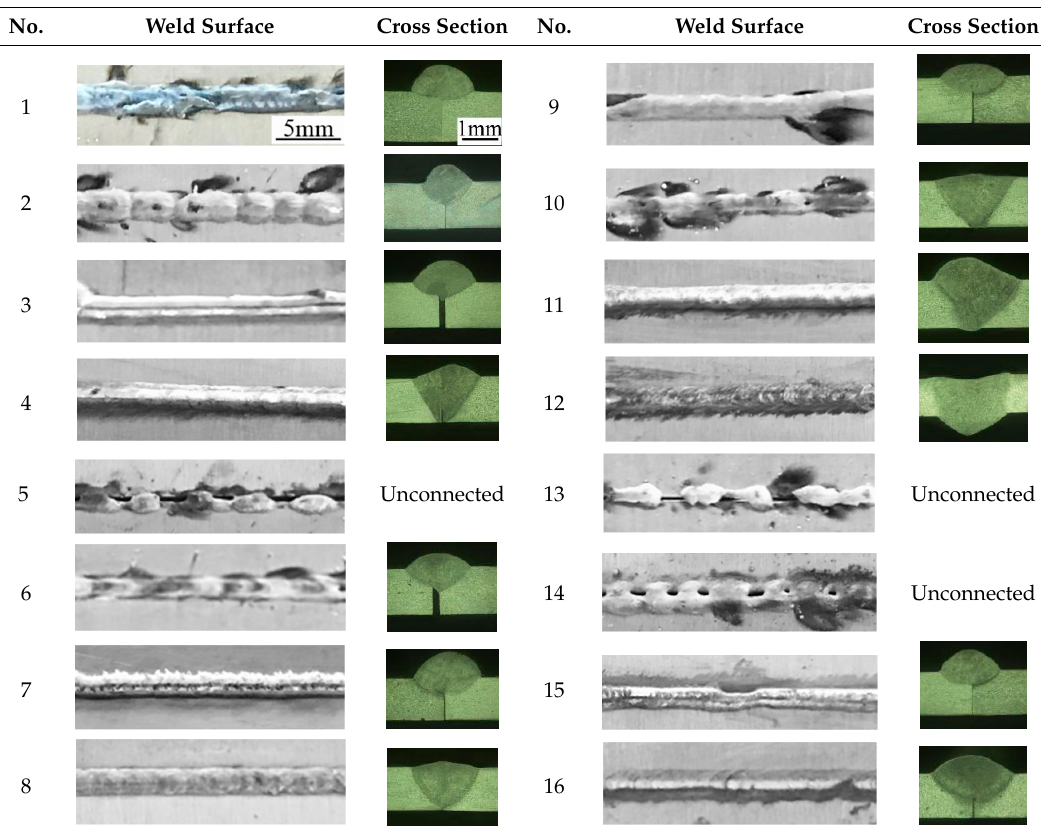
Table 3. Weld surface morphology and cross-section morphology.